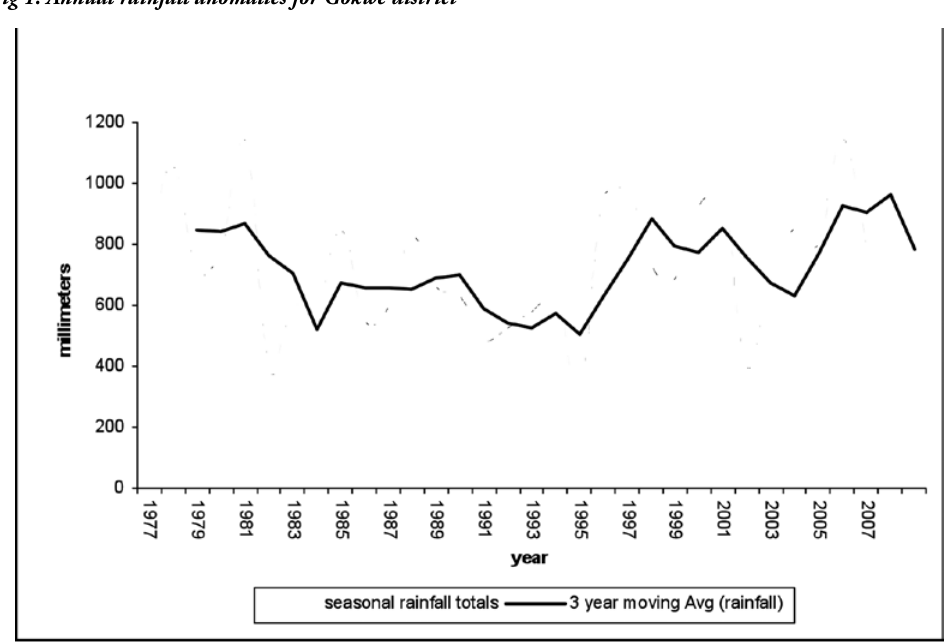
Fig 1. Annual rainfall anomalies for Gokwe district